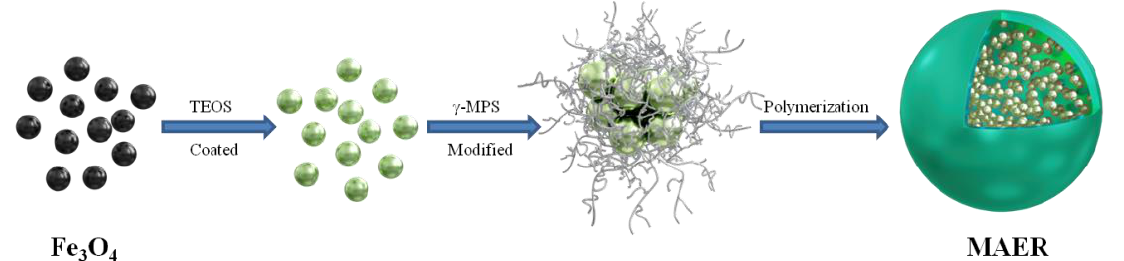
Figure 1. Schematic illustration of the preparation of magnetic anion exchange resin (MAER). Similarly, without adding magnetic nanoparticles, anion exchange resin (AER) was synthesized by the above